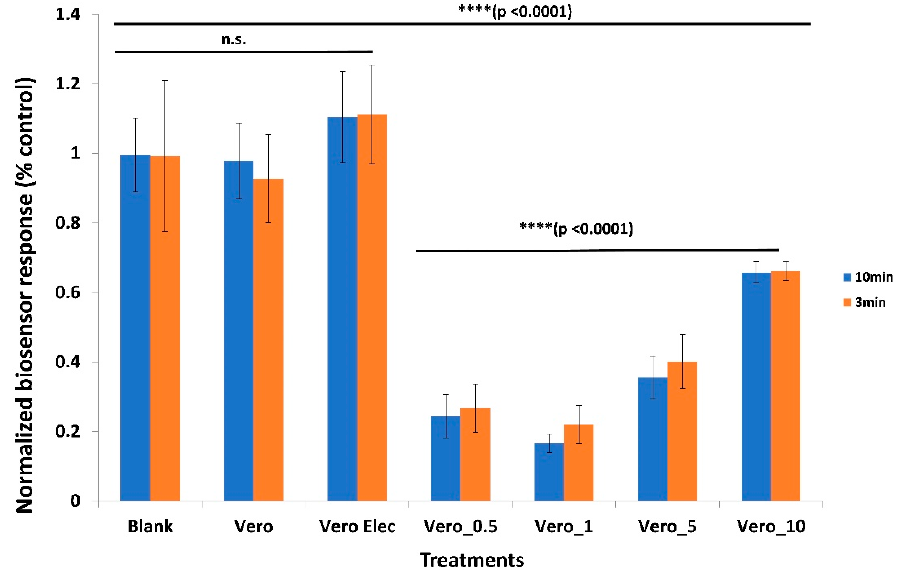
Figure 3. Distinct response of Vero / anti-S1 cells membrane-engineered with human chimeric antibodies (Vero_) against the SARS-CoV-2 spike S1 protein compared with the response of non-electroporated Vero cells (Vero) or electroporated but not antibody-engineered cells (Vero Elec). Cells were membrane-engineered with di ff erent antibody concentrations (Vero_0.5:0.5 µ g / mL; Vero_1:1 µ g / mL; Vero_5:5 µ g / mL; Vero_10:10 µ g / mL). Blank: response of the S1 protein solution added to cell-free electrodes. Results are presented after three (red columns) or ten minutes (blue columns) of sample–cell interaction. ****: statistically significant di ff erent results (p < 0.0001); n.s.: non-statistically significant di ff erent results. Results are expressed as normalized biosensor responses (% blank = control) (n = 24).